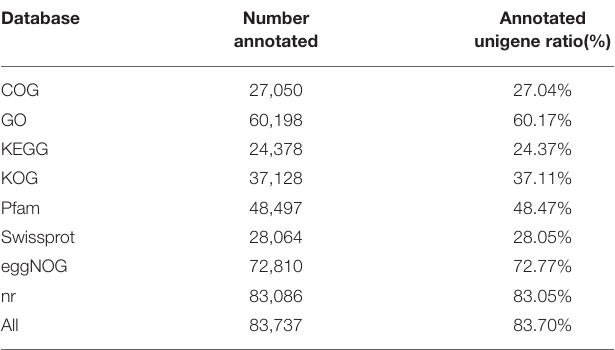
TABLE 2 | Summary statistics of annotations for Chinese fir.